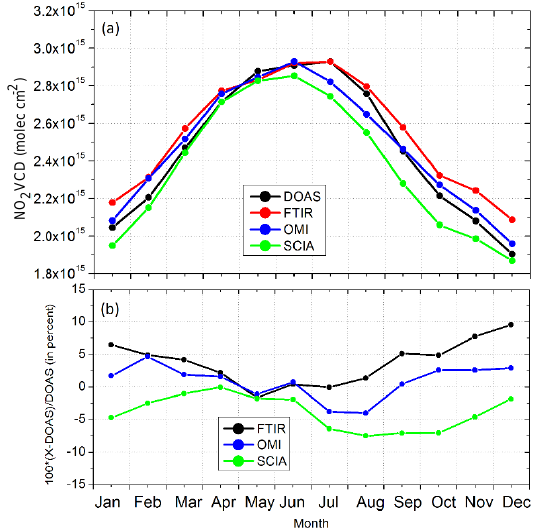
Figure 9. (a) Seasonal variation of NO 2 derived from DOAS (black), FTIR (red), OMI (blue) and SCIAMACHY (blue-green). (b) NO 2 relative difference from the instruments with respect to DOAS.